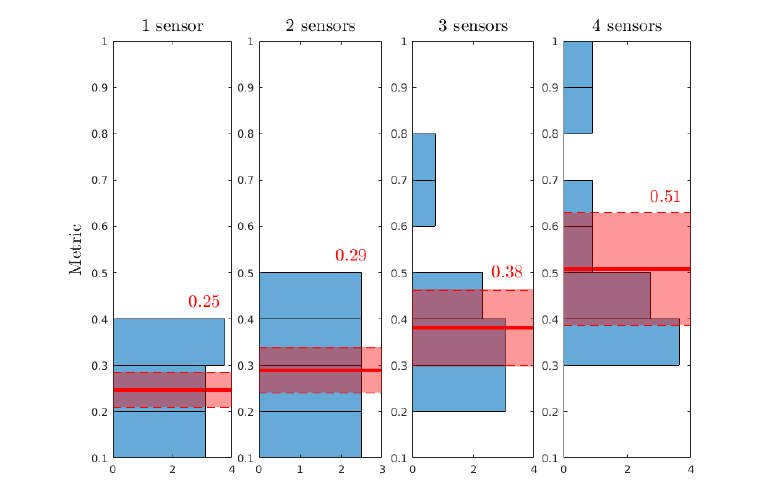
Figure 20. Histograms of the conditional entropy metric considering only ( a ) parameter depending on the number of